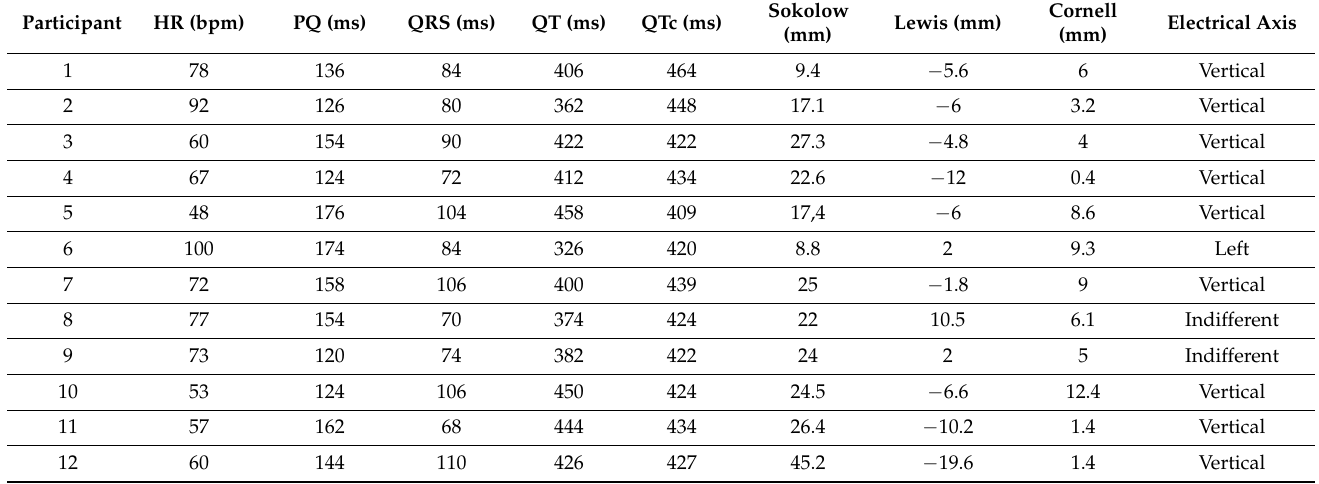
Table 1. Resting 12-lead